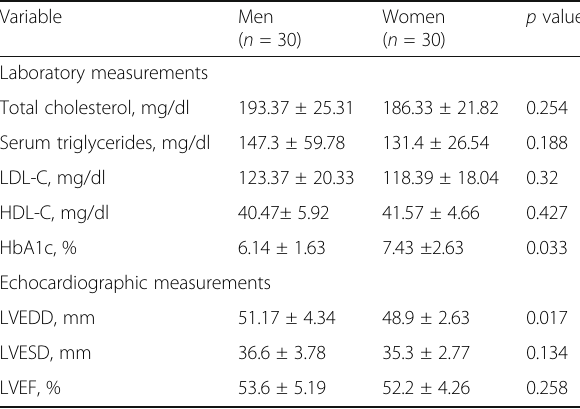
Table 2 Baseline laboratory and echocardiographic measurements